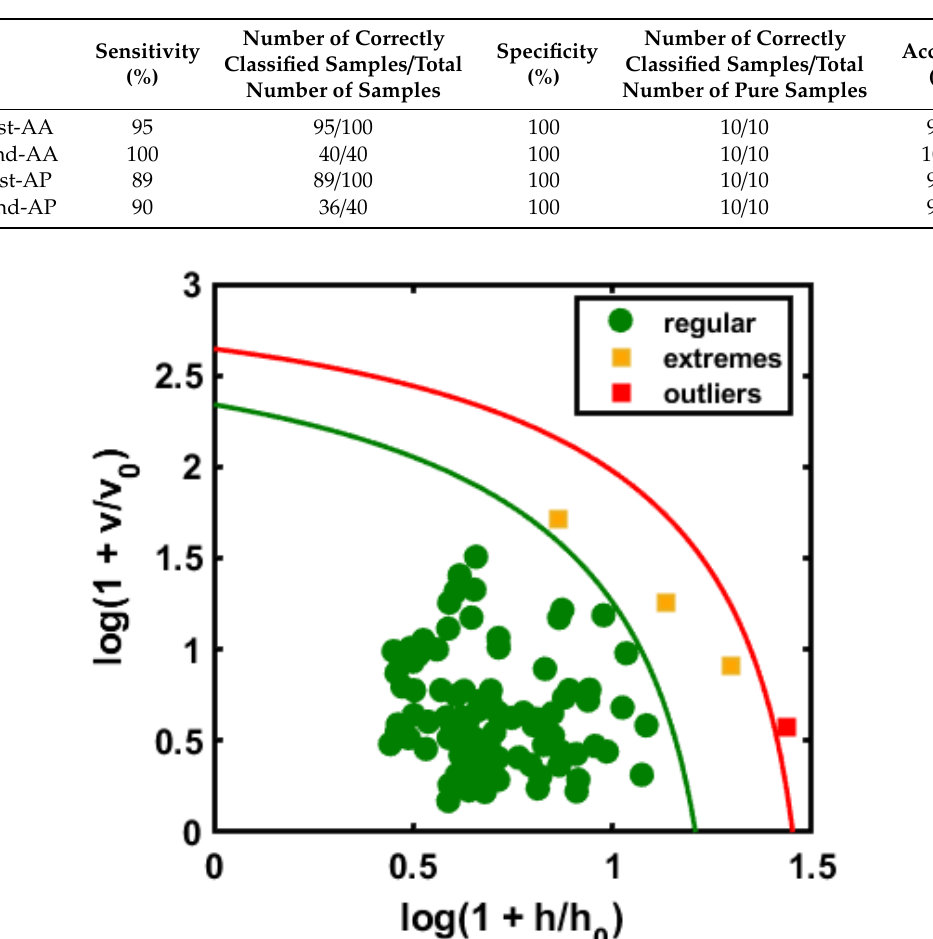
Table 2. DD-SIMCA classification results were obtained for validation datasets. (AA: Almond and apricot; AP: Almond and peanut).